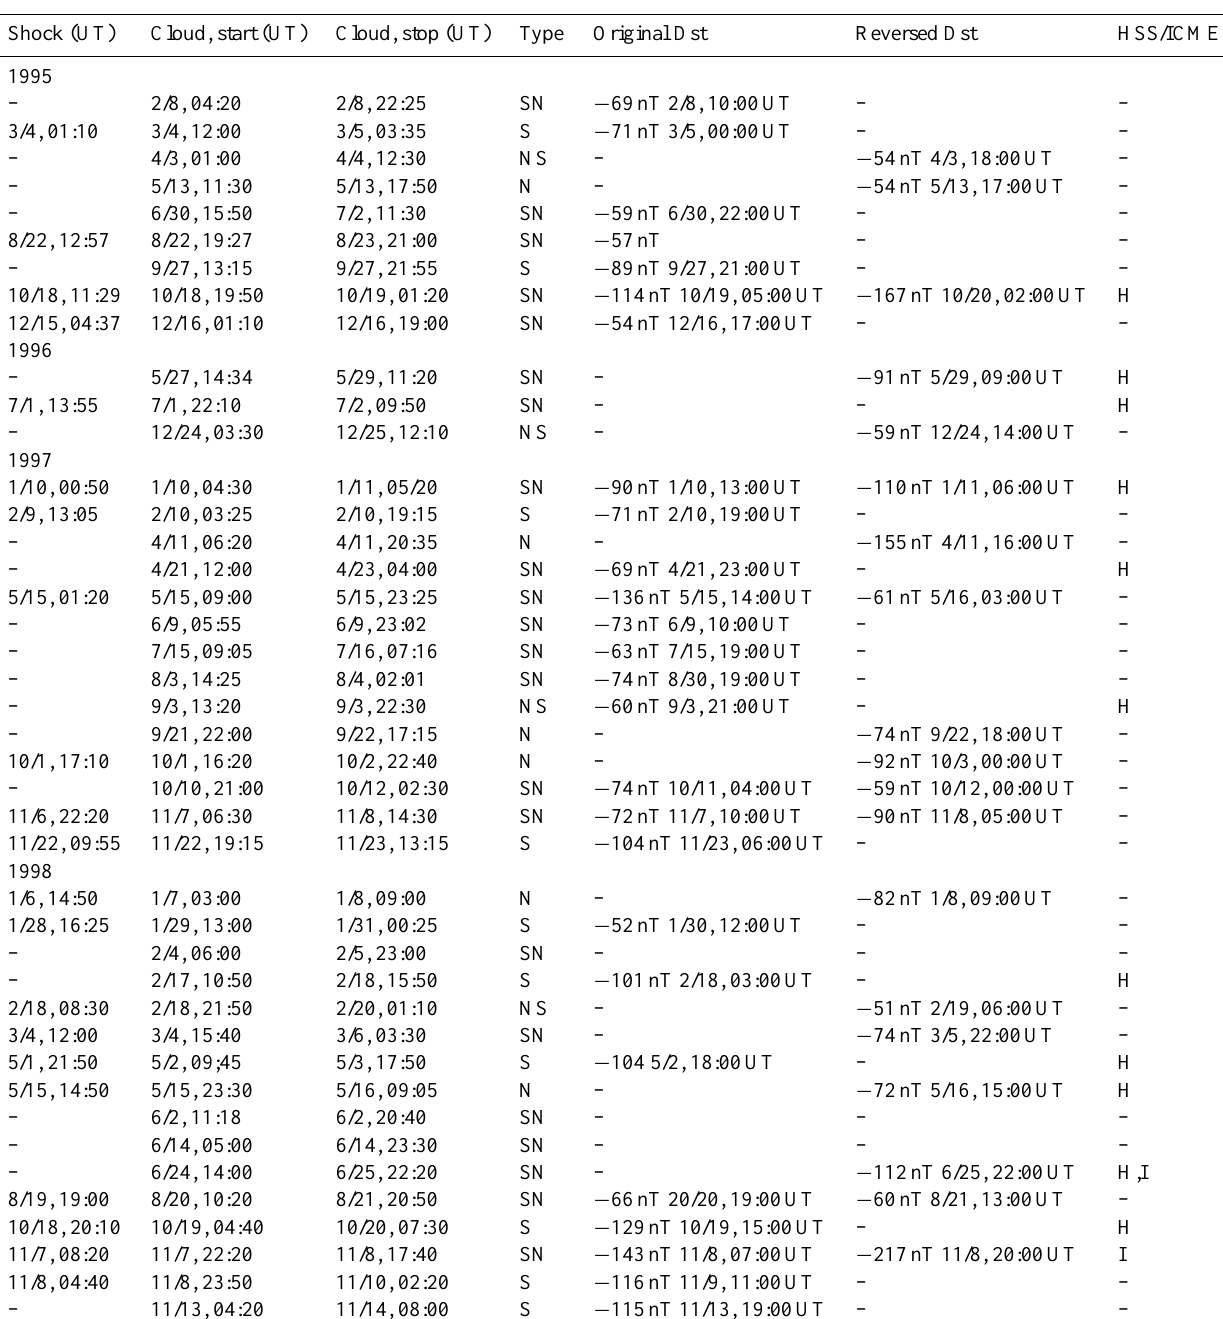
Table 1. Magnetic clouds during 1995–1998 (Period 1). The first three columns give the times when the shock and the magnetic cloud leading and trailing edges arrived at the magnetopause. Column “type” indicates the original B Z type of the magnetic cloud. The next two columns give the minimum Dst value (if < − 50nT) and the time when it was observed as estimated from the modified Burton’s formula (see Sect. 2) for measured and reversed B Z . Note that the estimated Dst values may differ from the Dst values calculated from magnetometer recordings. The last column indicates by “H” if the magnetic cloud was associated with a trailing higher-speed solar wind (HSS) and by “I” if it was overtaken by another